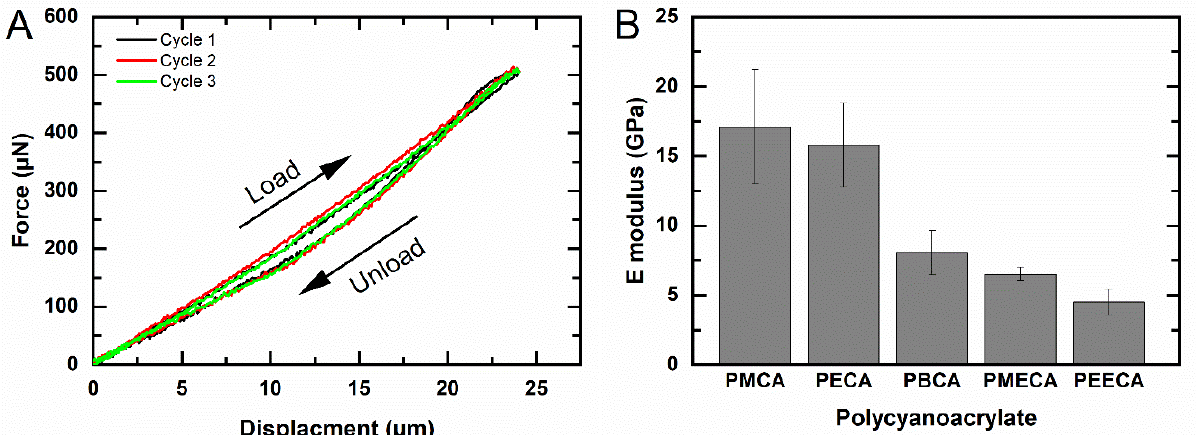
Figure 2. ( A ) Load–unload curve by indentation of PECA membrane over the square polymer skeleton (typical experimental error of the force sensor probe is 0.5 mN). ( B ) Elastic modulus E of free-standing PACA films with different side chains. Data represented as mean ± SD ( n = 3). Data quantified by Equation (4).